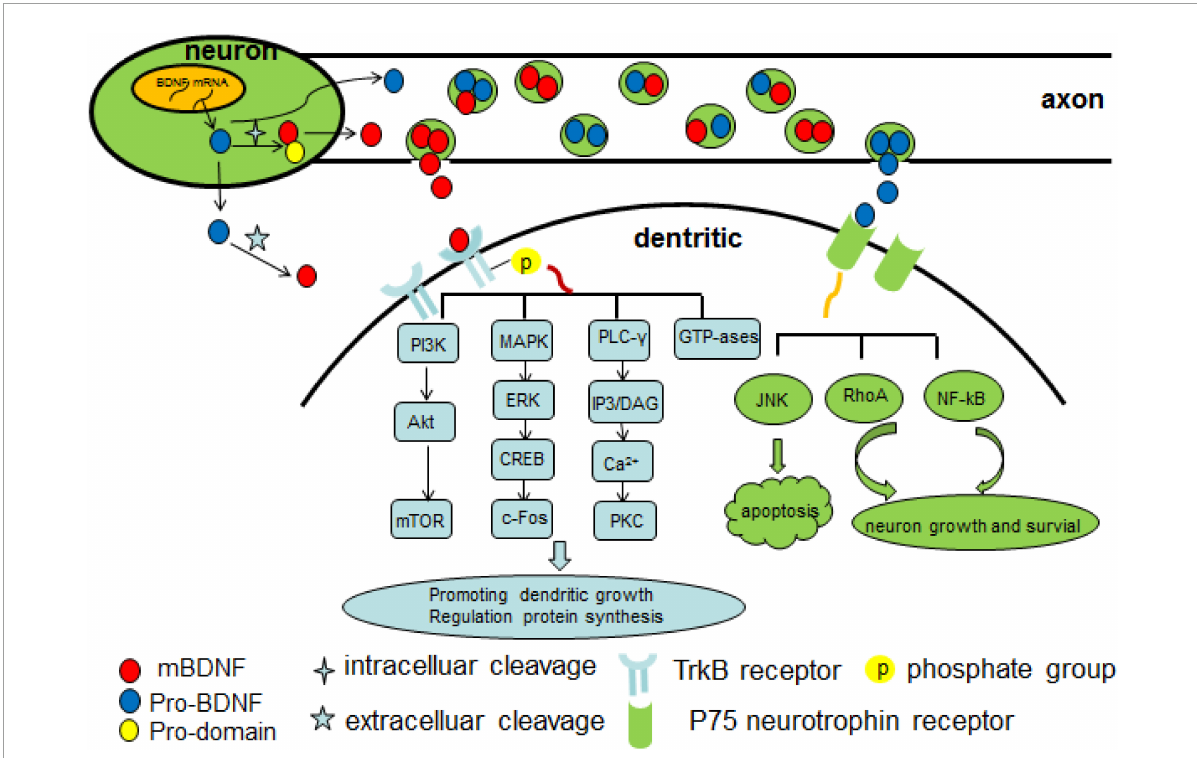
FIGURE1 Overview of Brain derived neurotrophic factor (BDNF) signaling cascade. There are two forms of BDNF–proBDNF and mBDNF. The proBDNF is initially synthesized and then cleaved intra or extracellularly into mBDNF. Two types of BDNF activate several important intracellular downstream signaling cascades as above shown by mediating TrkB receptor and p75 neurotrophin receptor. Pro-domain BNDF propeptide, PI3K phosphatidylinositol 3-kinase, MAPK mitogen-activated protein kinase, ERK extracellular-signal-regulated kinase, CREB Camp response element-binding protein, c-Fos transcription factor c-Fos, PLC- γ phospholipase C- γ , IP3 inositol 1,4,5-trisphosphate, DAG 1,2-diacylglycerol, PKC protein kinase C, GTP-ases guanosine triphosphate hydrolases, JNK c-Jun amino terminal kinase, RhoA Ras homolog gene family member, NF-kB nuclear factor kappa